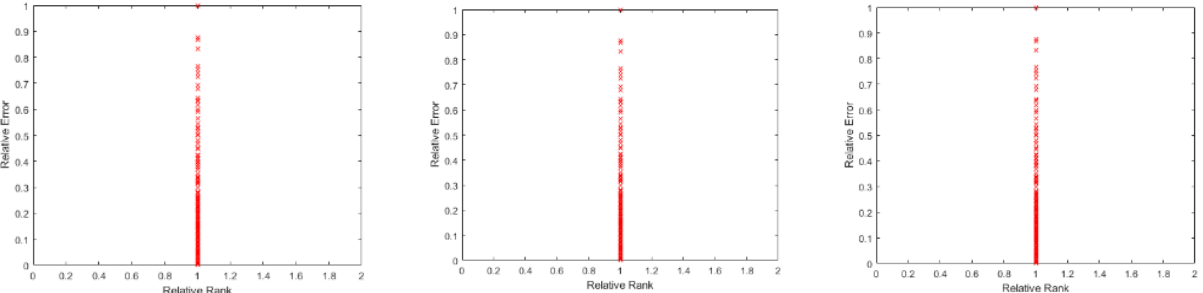
Figure 13. FC layers’ patterns distribution according the Relative Rank and Relative Error.